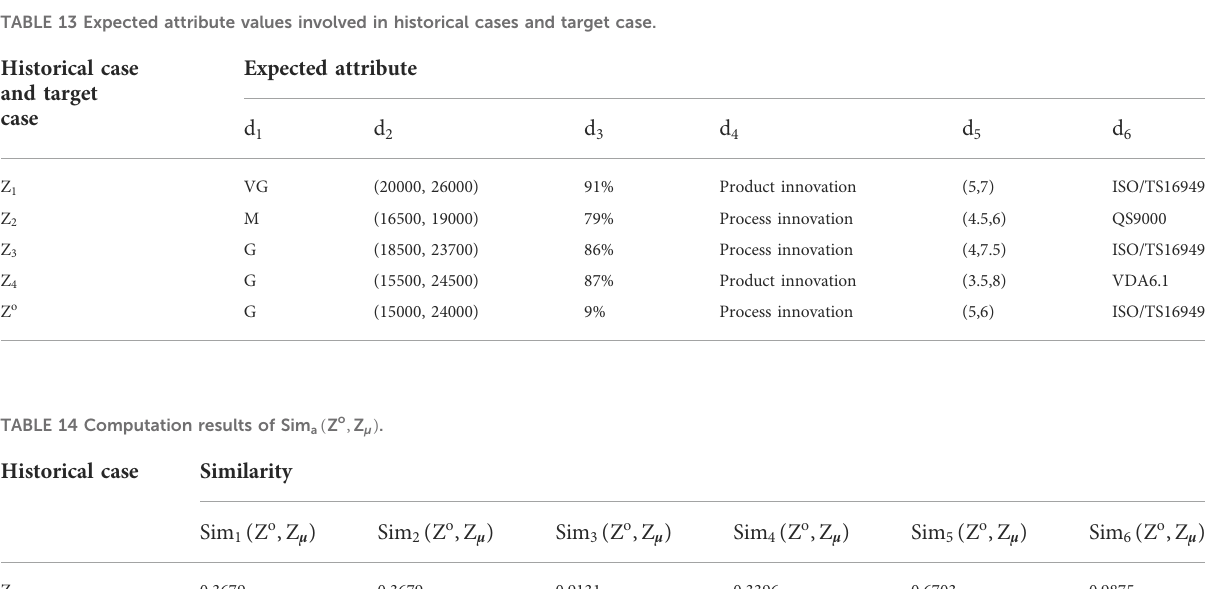
TABLE 13 Expected attribute values involved in historical cases and target case.